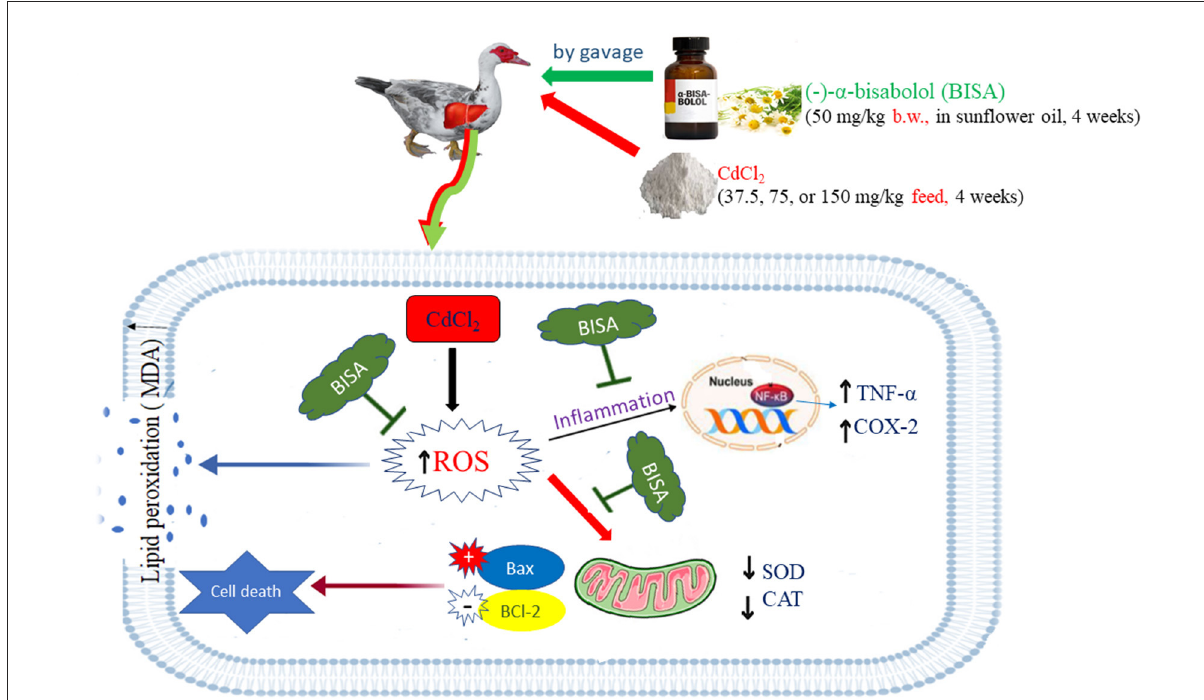
FIGURE6 The possible mechanisms of BISA-induced protection against Cd-induced liver toxicity in ducks. The schematic diagram elucidates that BISA exerts its effects via antagonizing the oxidative insult, inflammation, and apoptosis caused by CdCl 2